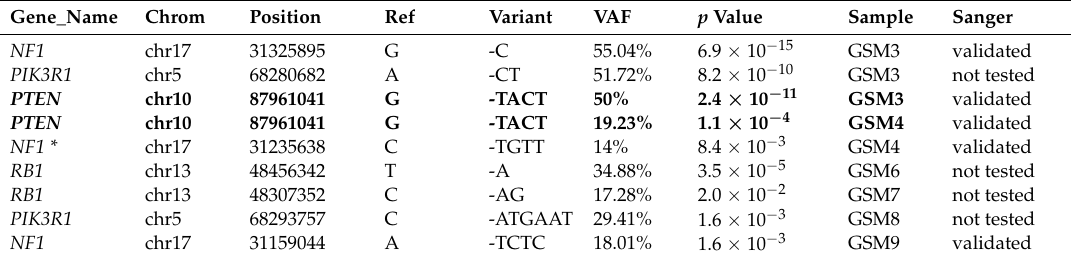
Figure 1. Summary of somatic genetic alterations in gliosarcomas. The panel represents somatically altered genes and chromosomal gain/loss in 10 gliosarcoma samples. Genetic alterations are ordered by decreasing the penetration in tumor tissue. Underlined alterations represent recurrent somatic alterations across analyzed samples, while an asterisk (*) marks alterations that were below 20% penetration threshold for somatic mutations or 15% penetration threshold for somatic indels. Those alterations were verified by ultra-deep sequencing. Table 2. Somatic indels in GSMs. Table is sorted by sample name and secondly by VAF (variant allele frequency) of indel in a tumor sample. p value is a somatic status p -value from Varscan2 analysis. In bold—the only detected recurrent position of the mutation in samples GSM3 and GSM4 in PTEN . All indels in a table are somatic coding indels that were found with minimal penetration of mutated allele >15% except one NF1 indel marked as *. Selected variants were validated with Sanger sequencing.